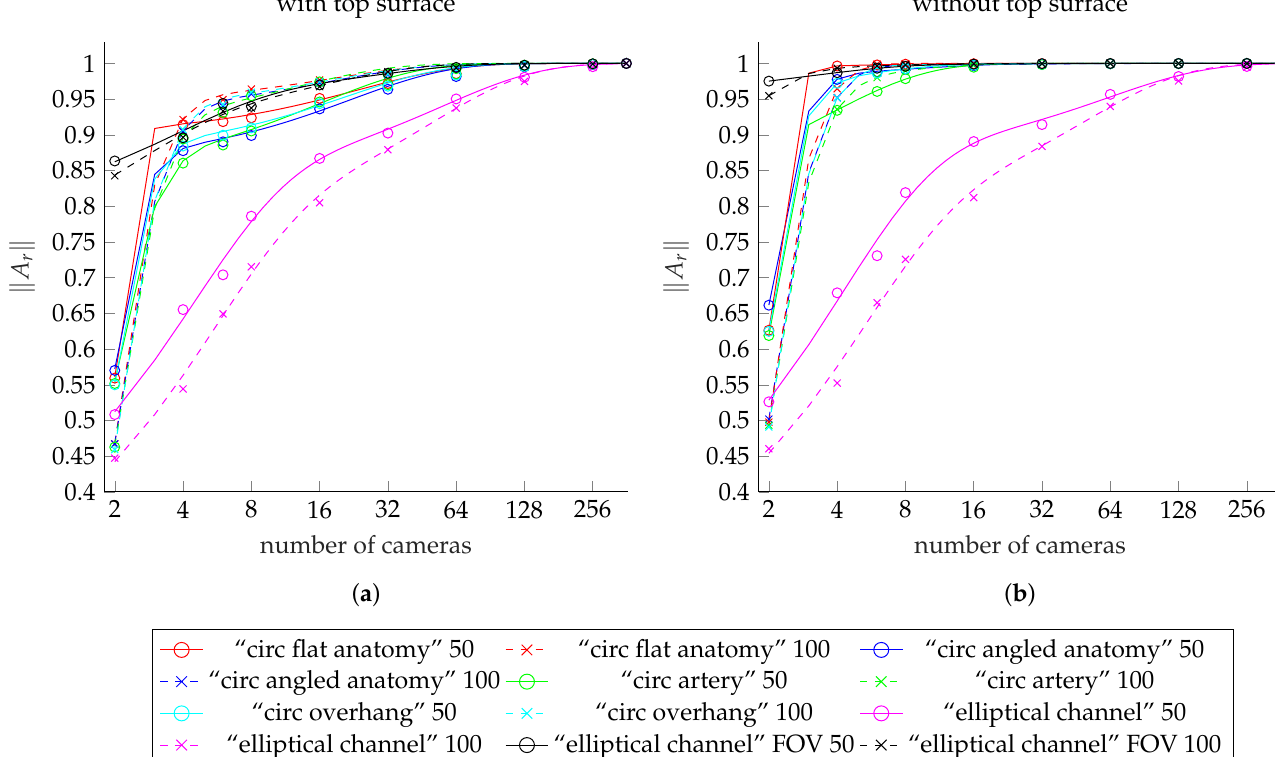
Figure 11. Comparison plot showing the fit functions to the reconstructable area values for each of our meshes. ( a ) shows the fit functions including the top surface, ( b ) shows the fits to data excluding the top surface. The curves for the meshes with 50mm deep channel are solid lines. The dashed lines shows the curves of the meshes with 100mm deep channel. The colors red, blue, green, and cyan represent the meshes “circ flat anatomy”, “circ angled anatomy”, “circ artery”, and “circ overhang”, in this order. Magenta belongs to the elliptical channel models, using the smaller FOV. The black curves belong to elliptical channel fits with larger FOV. The scattered markers represent the measured area